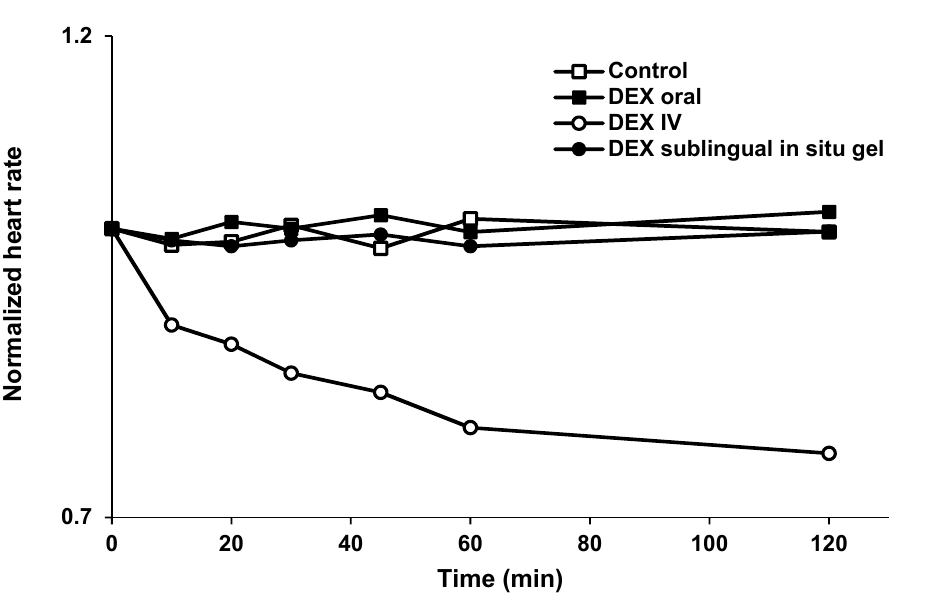
Figure 6. Normalized heart rates in rabbits following sublingual administration of DEX in situ gel (F3), oral and IV administrations of DEX free drug solutions.